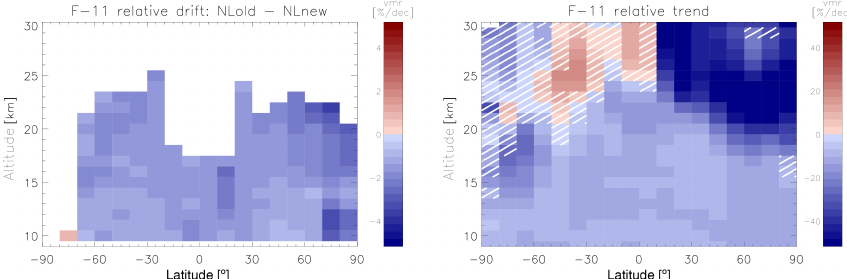
Figure 34. Left panel: altitude–latitude cross section of the instrument drift in MIPAS CFC-11. This drift is calculated by comparing the temporal evolution of CFC-11 from two different setups. One setup uses nonlinearity correction coefficients used for the bulk MIPAS retrieval to date. The other uses newly suggested time-dependent nonlinearity correction coefficients (Eckert et al., 2014, Sect. 3.3). The drift is shown in relative terms, referring to the mean CFC-11 mixing ratio in the middle of the time series. Blueish tiles indicate that the new coefficients result in higher CFC-11 mixing ratios, while reddish tiles indicate the opposite. White areas indicate that there were too few or no data points available to estimate a drift properly. Right panel: altitude–latitude cross section of relative MIPAS CFC-11 trends without drift correction, calculated from data covering January 2005 to April 2012. The trend is weighted with the CFC-11 mixing ratio of the middle of the time series for each tile. Blueish tiles indicate declining CFC-11 mixing ratios, while increasing mixing ratios are represented by reddish tiles. Hatching indicates that the trends are either not significant at 2-sigma level or that χ 2 is more than 10% different from one. Note different color